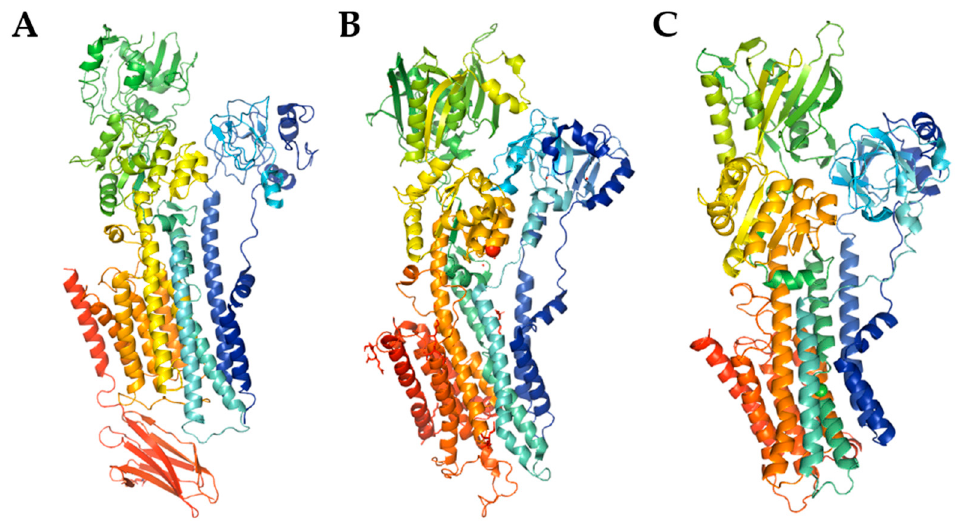
Figure 1. The model of PMCA (( A ), PDB entry code 6A69) and SERCA (( B ), PDB entry code 3W5C) structures, and SPCA structure prediction using SWISS-MODEL ( C ). The cartoon models were generated with PyMOL.